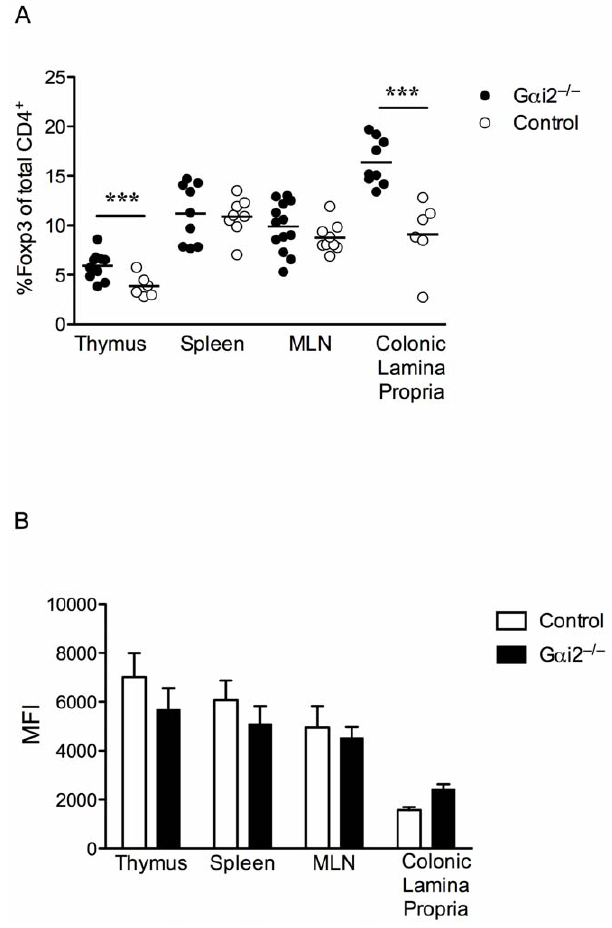
Figure 1. Frequency and intensity of expression of FoxP3 in CD4 + T cells in central, peripheral and mucosal lymphoid tissue. A. Frequencies of FoxP3 + cells in gated CD4 + T lymphocytes in colitic G a i2 2 / 2 mice were compared to age-matched control mice, (n $ 6 in each group) as determined by FACS analysis. Each symbol represents one mouse and the mean of each group is indicated by a line. Results are shown from at least three independent experiments, where ***=p # 0.001. B. Intensity of FoxP3 expression, measured as median fluorescence intensity (MFI) of gated CD4 + FoxP3 + lymphocytes. Results are shown as mean values 6 SD of n=4 to 6 mice per group, pooled from at least three independent experiments.